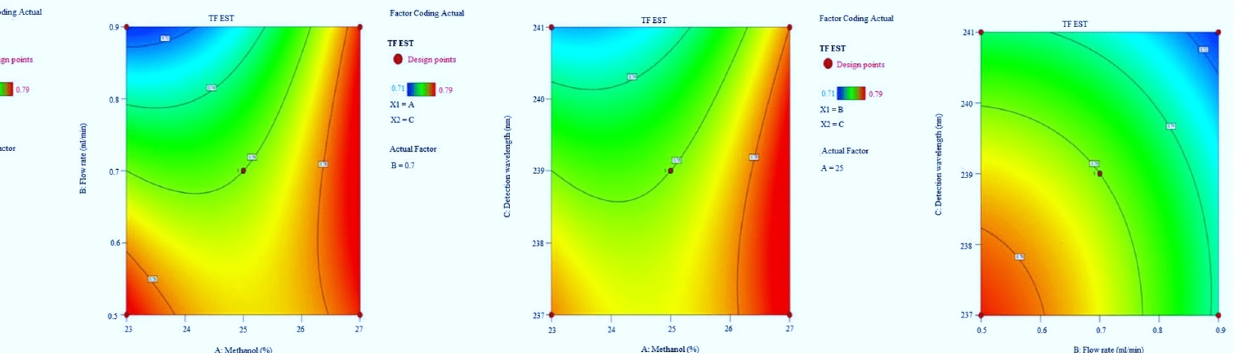
Figure 4. Contour plots for EST tailing factor in terms of AB, AC, and BC.